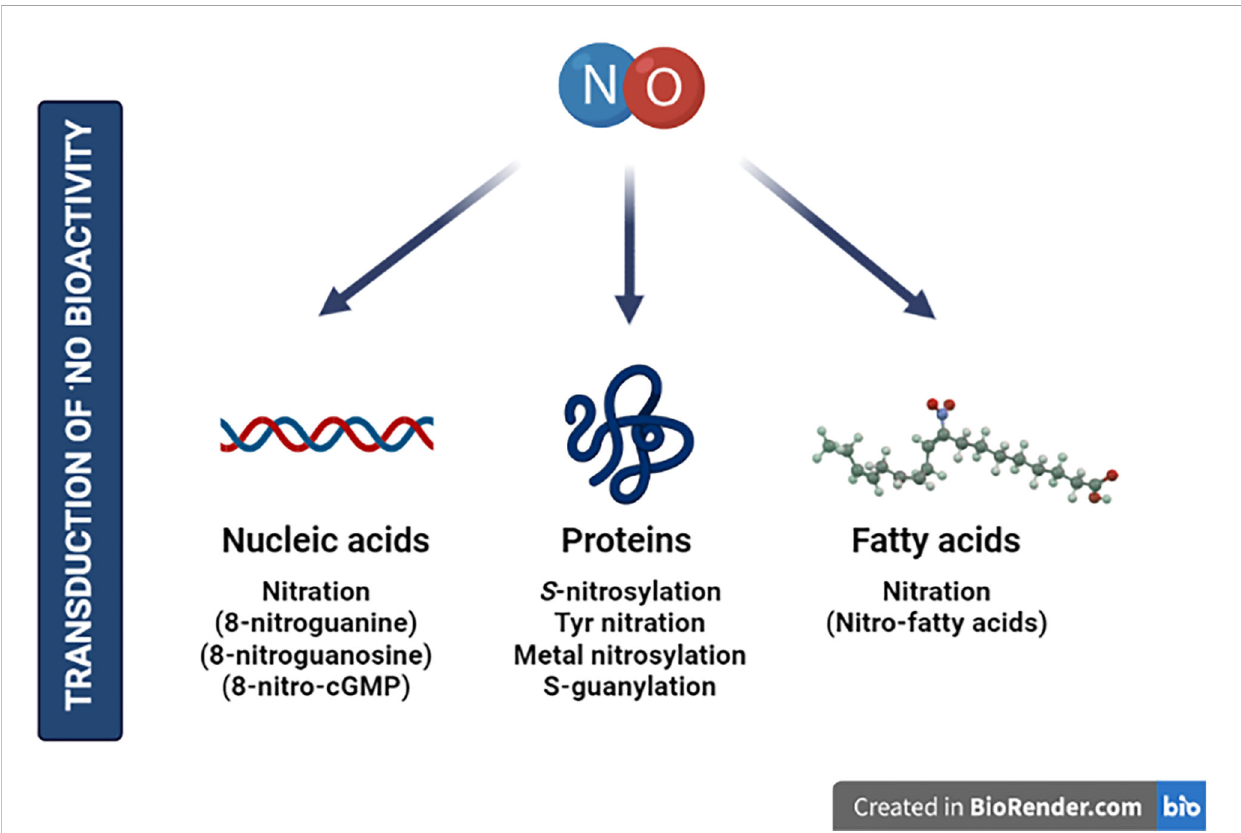
FIGURE 1 Nitric oxide is considered an essential gasotransmitter for the transduction of bioactivity in plants. Although the main effects described correspond to protein targets, other molecules are susceptible to be modi fi ed by NO — including nucleic acids or fatty acids — highlighting molecular points to be explored in future research. Created by